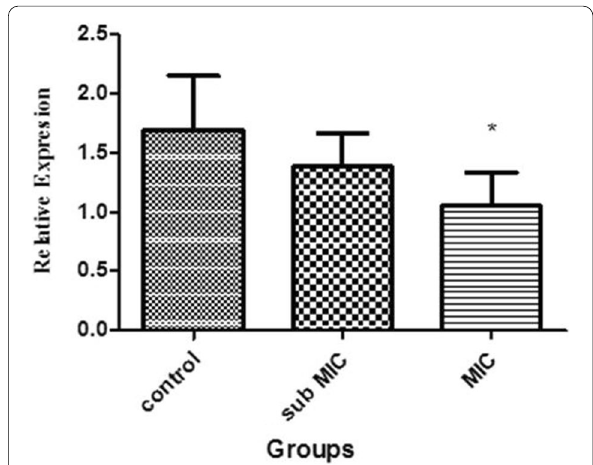
Figure 1 Real-Time PCR was used to analyze the adeB gene expression in A. baumannii isolates. A significant decreased in adeB gene expression was observed in MIC